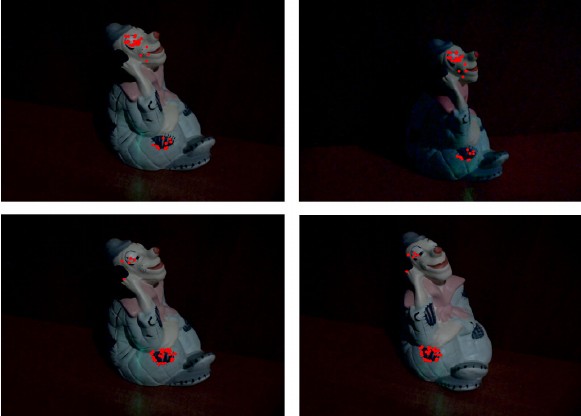
Figure 6: Matched points on pairs formed by the right image of the first scan position (left) with the left image (above) and the right image (below) of the second scan